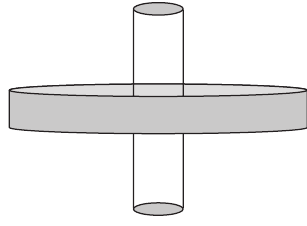
Figure 2: Graphical representation of a rectangular radial fin.